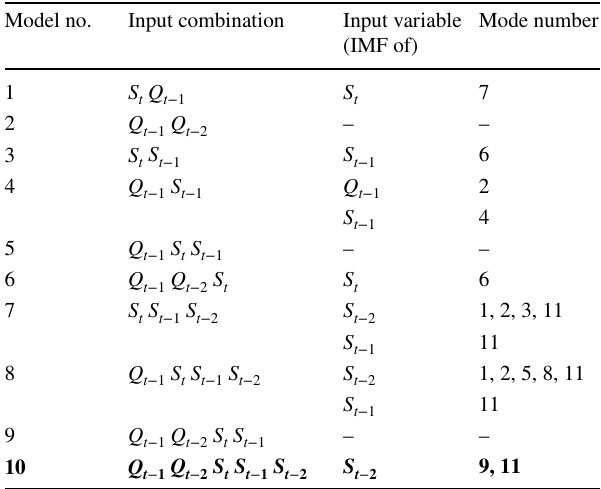
Table 2 Description of models and omitted modes in developed GP models at different timescales